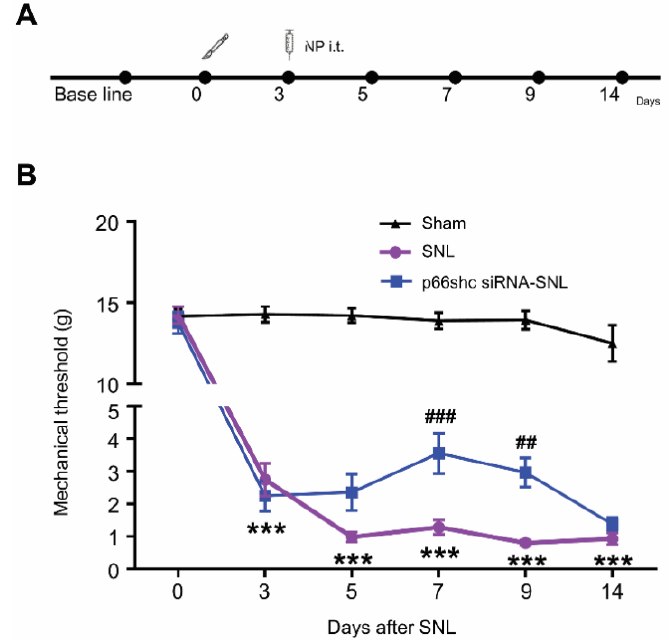
Figure 2. The degree of pain confirmed by the mechanical threshold after spinal nerve ligation (SNL). ( A ) experimental timeline of this study; ( B ) After three days of SNL-induced neuropathic pain, the mechanical threshold was identified using the von Frey filament test to confirm the analgesic effect of p66shc siRNA-PLGA NPs ( n = 6 in each group). Data are expressed as means ± SEM (two-way ANOVA with Dunnett’s post hoc test, *** p < 0.001 vs. sham group, ### p < 0.001, ## p < 0.01 vs . SNL group.